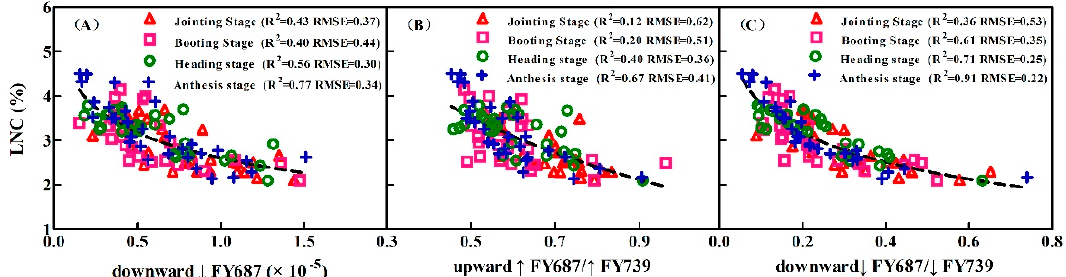
Figure 8. LNC plotted against SIF yield indices at different growth stages: ↓ FY687 ( A ); ↑ FY687/ ↑ FY739 ( B ) and ↓ FY687/ ↓ FY739 ( C ). The data are shown in red (triangle) for jointing stage samples, magenta (square) for booting stage samples, green (circle) for heading stage samples, and blue (plus) for anthesis stage samples. All regressed lines are statistically significant ( p < 0.001).